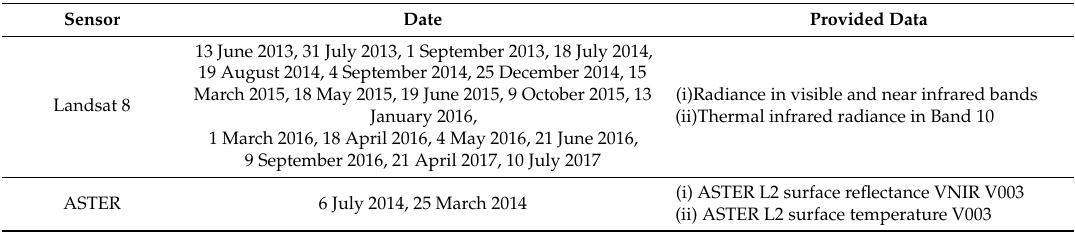
Table 1. The image acquisition dates of Landsat 8 and ASTER and the provided data. Sensor Provided